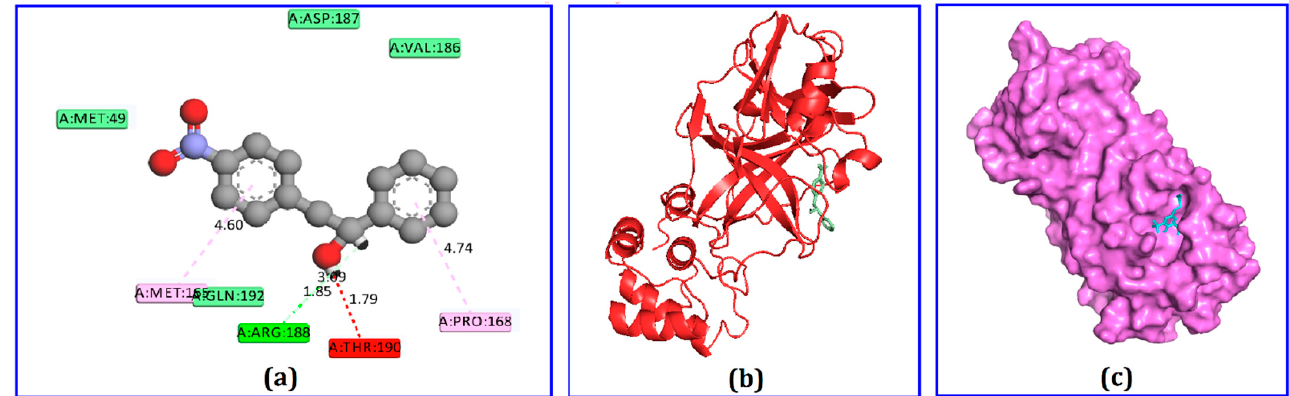
Figure 4. The non-bonded interaction of phenethyl alcohol and main protease from SARS-CoV-2. ( a ) 2D interaction pattern of main protease from SARS-CoV-2 and hexacosane, ( b ) 3D binding interaction, and ( c ) surface view of the docked complex.